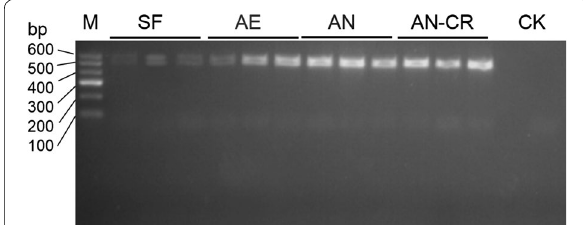
Fig. 1 PCR products of the V3-V4 region of bacterial 16S rRNA gene with primers 341F/806R. SF sows’ fecal group, AE aerobic group, AN